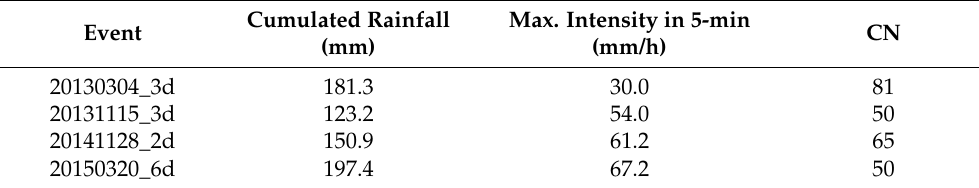
Table 3. Summary of the characteristics of the rainfall events analysed for Case Study 3. Cumulated Event